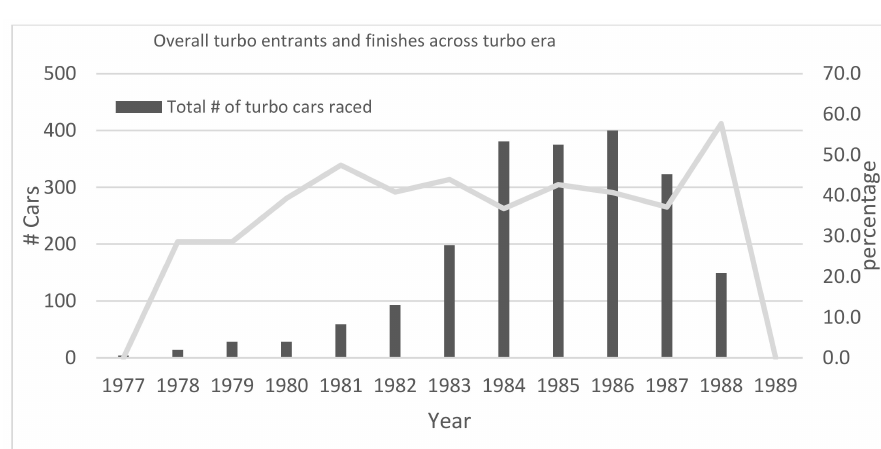
Figure 3. Renault pole position across turbo period.